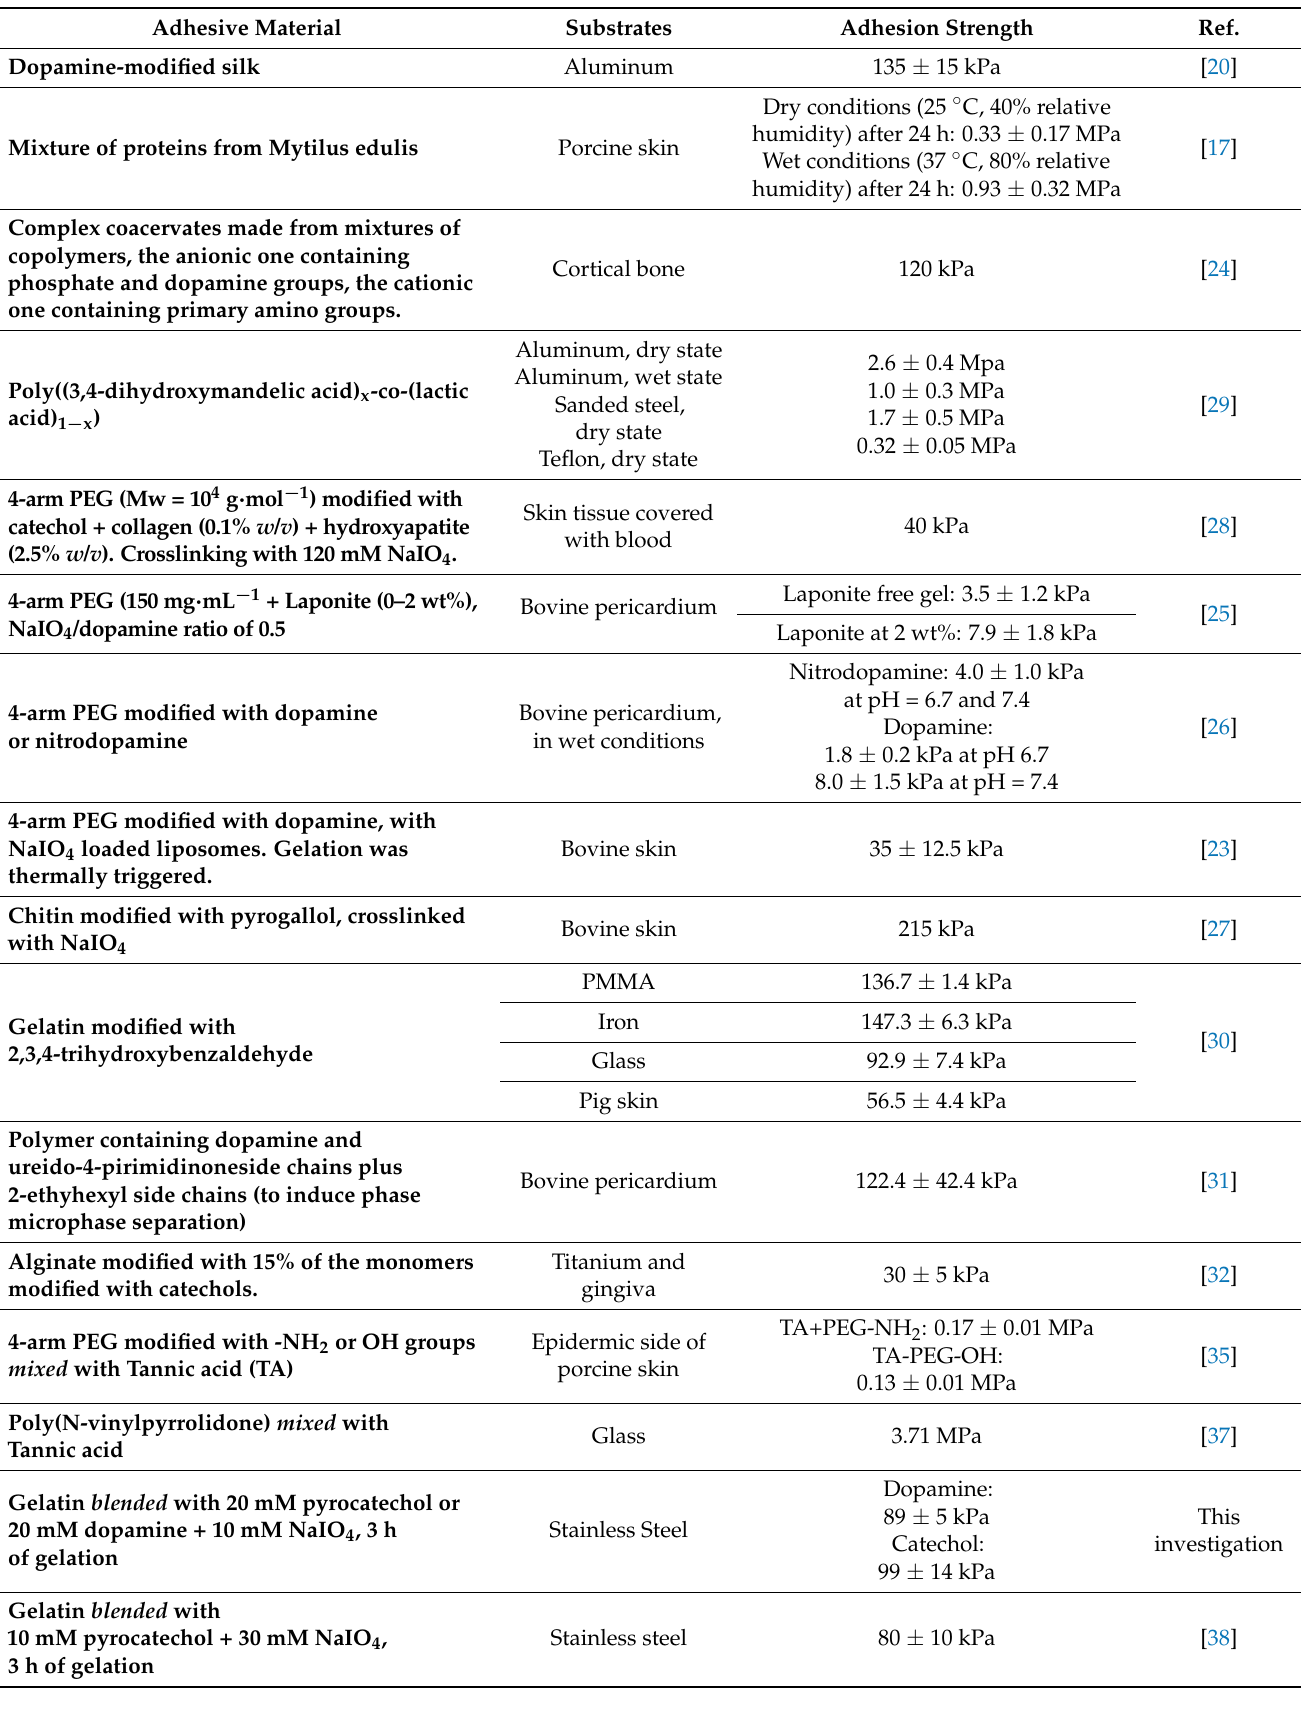
Table 1. Literature survey of the adhesion tests performed on catechol-containing